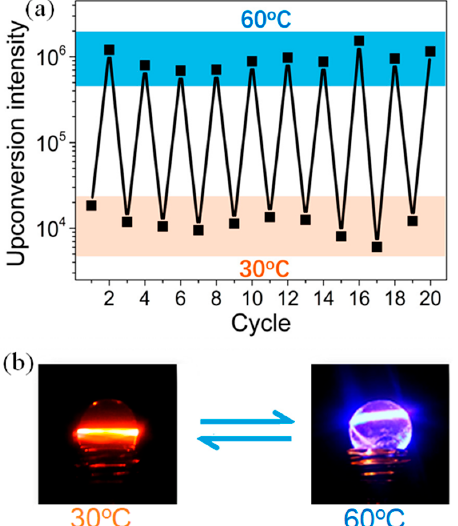
Figure 7. ( a ) Upconversion intensity of the PAAS hydrogel containing PdTPP-DPA-Toluene-Tween-80 microemulsion in the heating-cooling cycles ( λ ex = 532 nm). ( b ) Digital photo of the emission of UC hydrogel at 30 °C (orange-red) and 60 °C (blue). Adopted with permission from [42]. Copyright 2017 American Chemical Society.